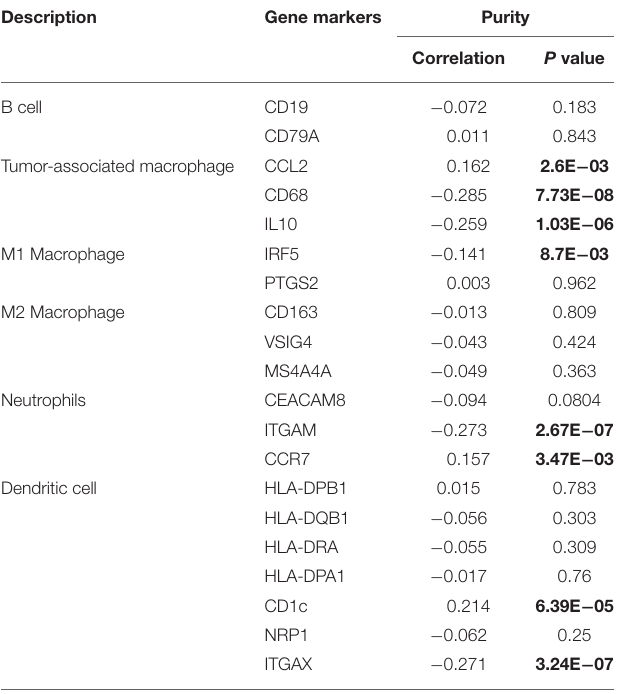
TABLE 2 | Correlation analysis between CLEC3B and related genes and markers of immune cells via TIMER.